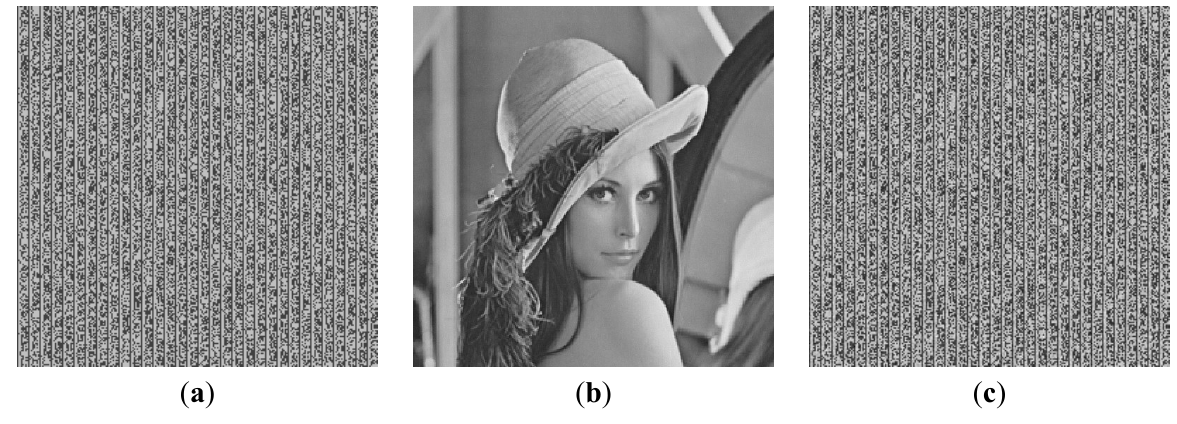
Figure 7. ( a ) The array transformed from the secret text with m = 1. ( b ) The image embedded with hidden data with α = 0.02. ( c ) The recovered transformed array. The recovery accuracy is 100%.